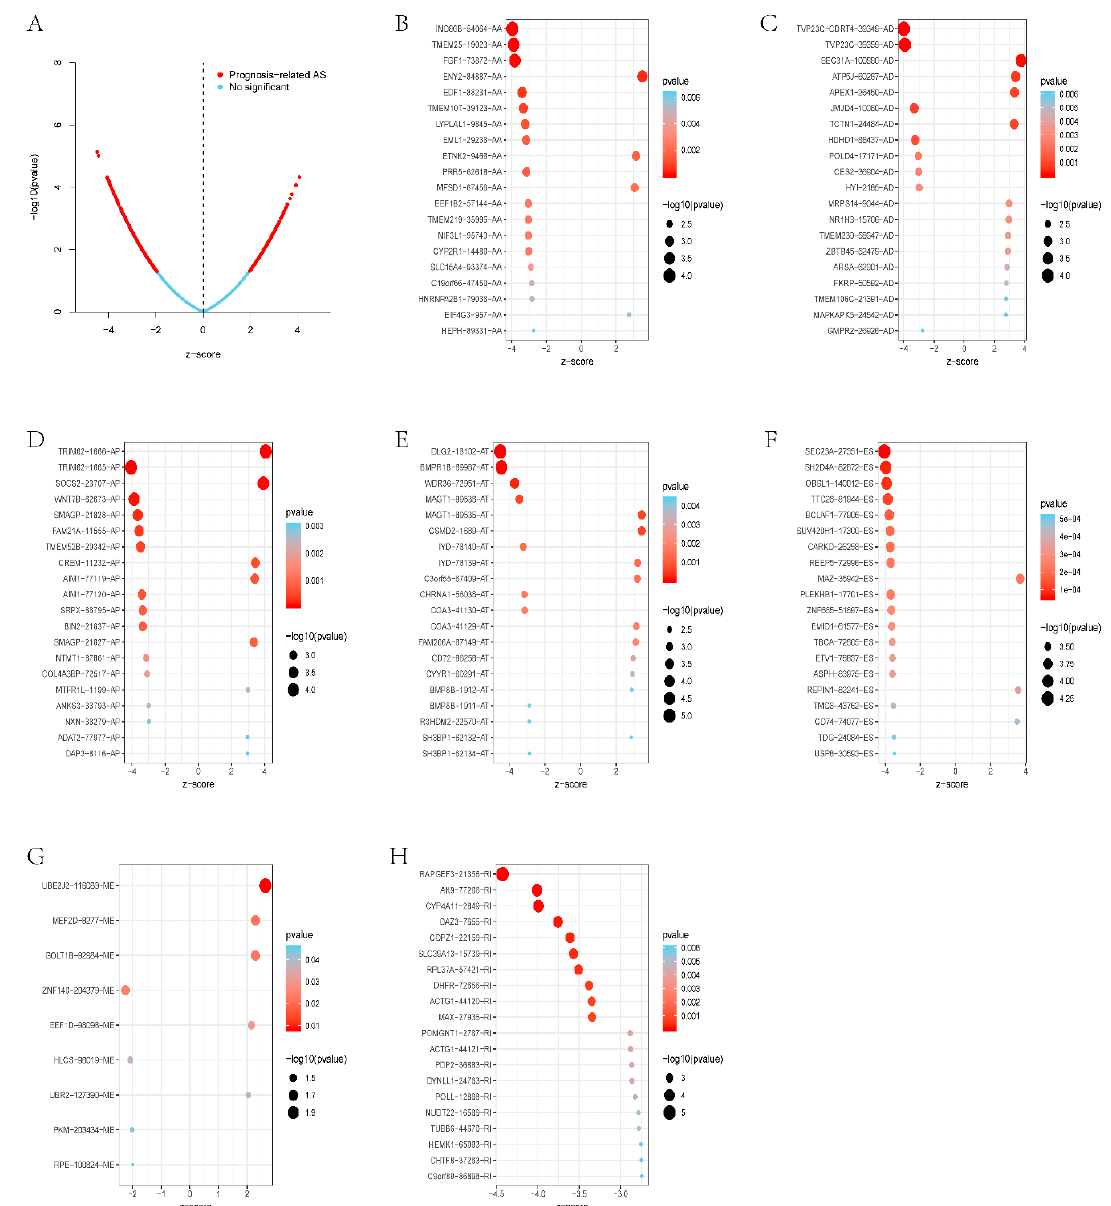
Figure 3. Most important AS events in GBC. ( A ) The red dots represent AS events that are prominently associated with patient survival. The blue dots represent AS events without correlation. ( B ) The top 20 AS events correlated with the clinical outcome based on alternate acceptors; ( C ) alternate donor sites; ( D ) alternate promoters; ( E ) alternate terminators; ( F ) exon skips; ( G ) the top nine AS events correlated with the clinical outcome, based on mutually exclusive exons; ( H ); retained introns.